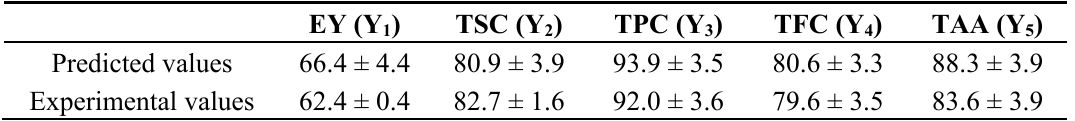
Table 5. Validation of the models. The predicted and experimental values for the encapsulation yield (EY) and the retentions of the total saponin (TSC), total phenolic (TPC) and total flavonoid (TFC) content and the total antioxidant activity (TAA) for the bitter melon extract encapsulated powder obtained for the optimal